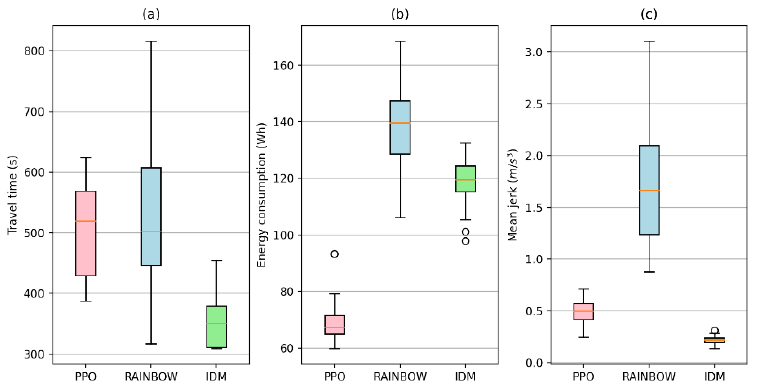
Figure 8. The evaluation results for PPO, RAINBOW, and IDM. ( a ) Travel time; ( b ) Energy con- sumption; ( c ) Mean jerk.